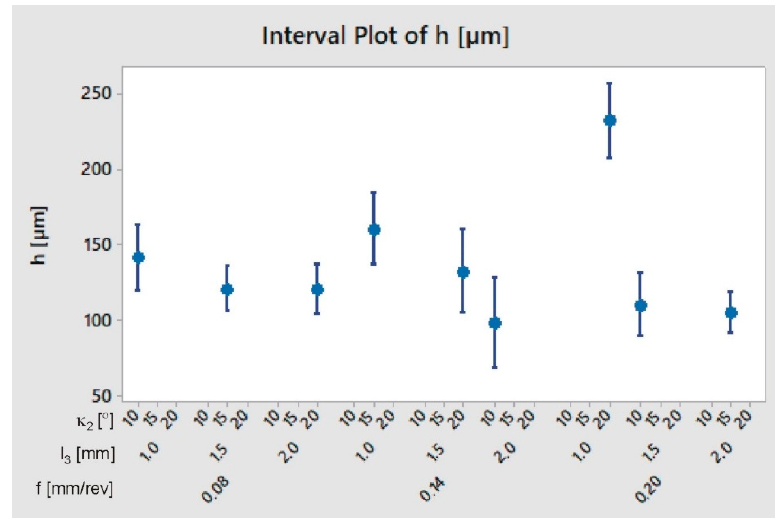
Figure 8. Burr height h depending on the shape of the tool used and on the feed.